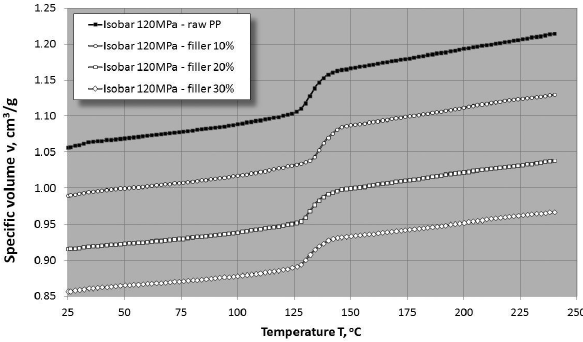
Figure 3: Example of P-v-T characteristic for raw PP Moplen RP2380 and with 10%, 20%, 30% of filler content obtained at a high pres- sure 120MPa